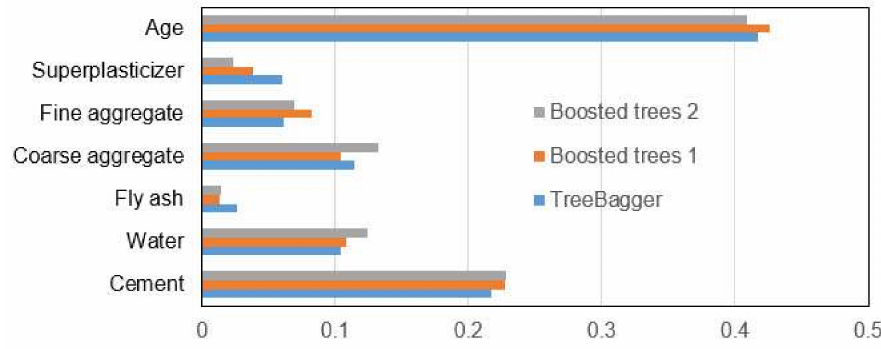
Figure 16. Significance of individual variables in TreeBagger and boosted trees